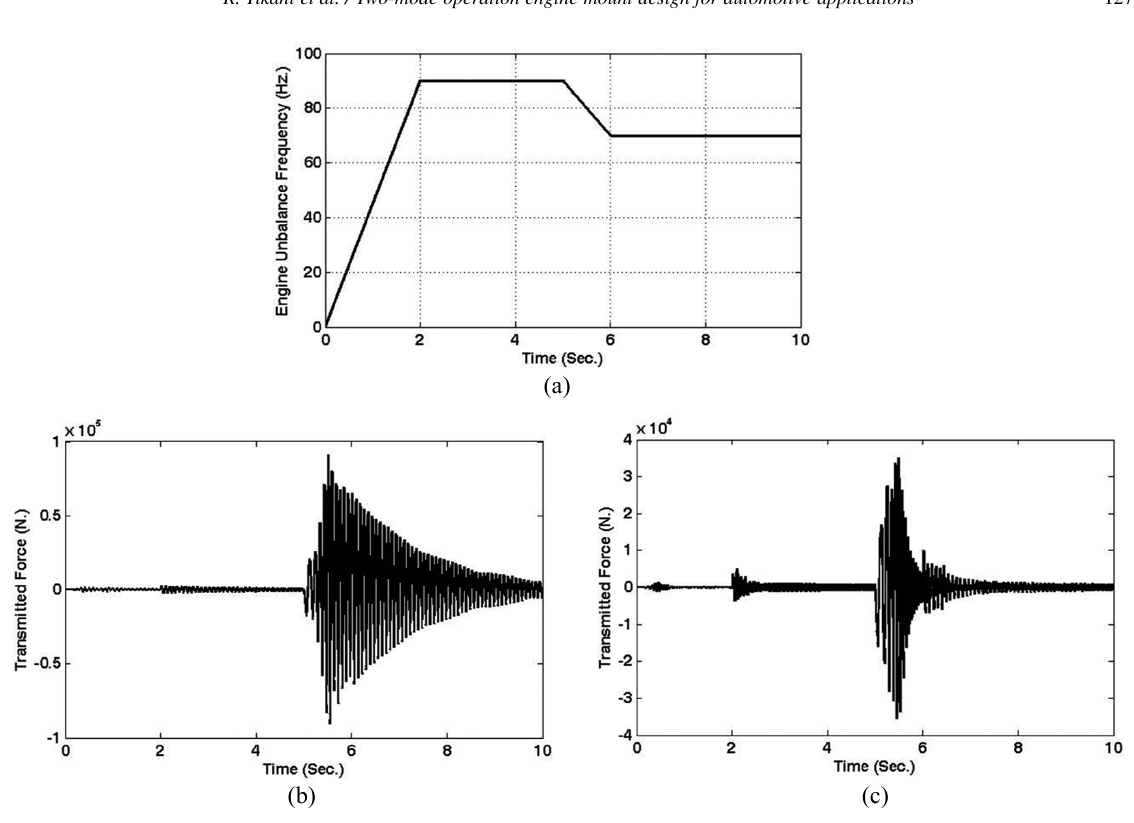
Fig. 16. (a) Engine rotational frequency, (b) Transmitted force in the passive mode, (c) Transmitted force after implementing control strategy. when needed. The new design was described and its mathematical model was presented. It was shown that the new design can provide vibration and noise isolation at a wide range of frequencies; also, one can converted it to a damper by applying required force. To control the proposed hydraulic engine mount, a control strategy was suggested that adjust the input force to the rubber disk to achieve best vibration isolation in two-mode operation meaning isolating mode in the highway driving condition and damping mode in the shock